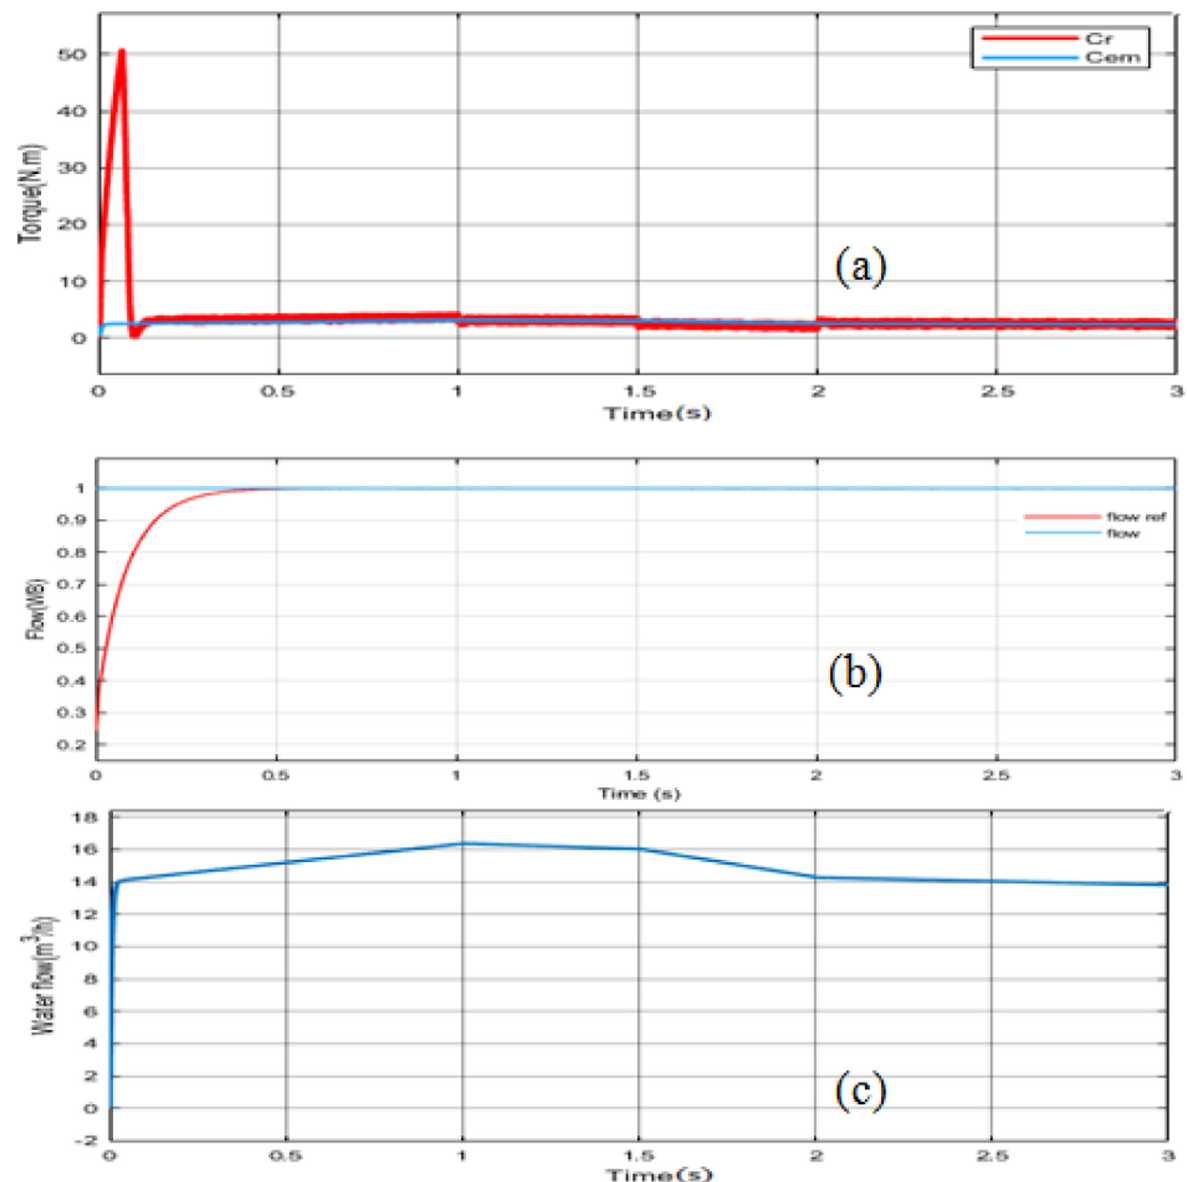
Fig. 18 Response of the system to the variation of G and